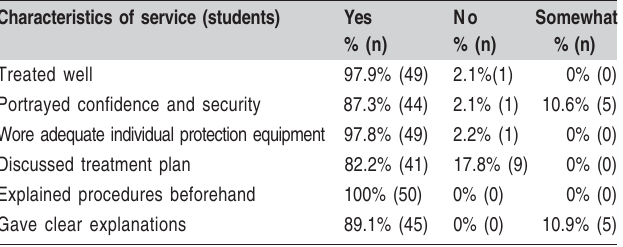
Table 2 – Characteristics of service given by students, according to the